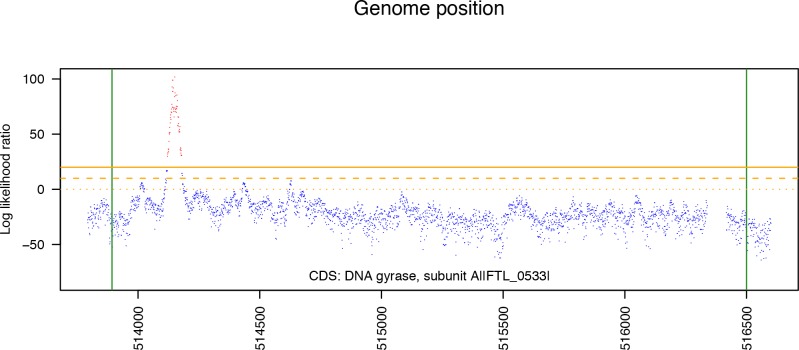
The test statistic values for a short region of the DNA gyrase A gene in one of the Cipro resistant F. tularensis isolates.The log likelihood ratio has a clear peak in this region. Candidate SNP positions were identified by looking for regions of the genome where the log likelihood ratio exceeds a fixed threshold.